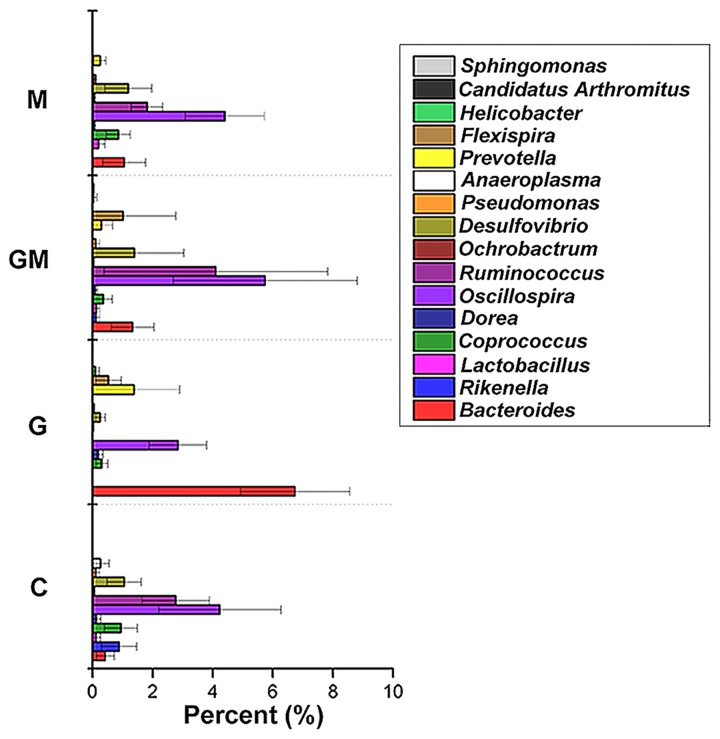
Core bacterial genera in the colon of mice in the four different groups. To test for evidence of a core bacterial community in the colonic samples, the compute_core_microbiome function within QIIME was used, requiring the core OTUs to be present in at least 90% of the samples as based on the non-rarefied data set. C, control; G, glucan; M, MCC; GM, glucan and MCC.